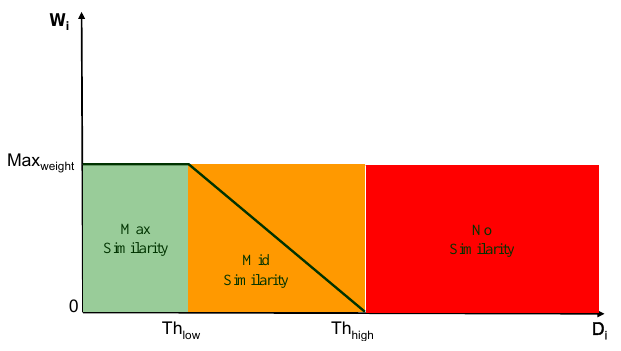
Figure 10. Weights assignment (Similarity Evaluator Block). The i-th weight denotes the degree of similarity between the central pixel in the filter mask and the i-th pixel in the